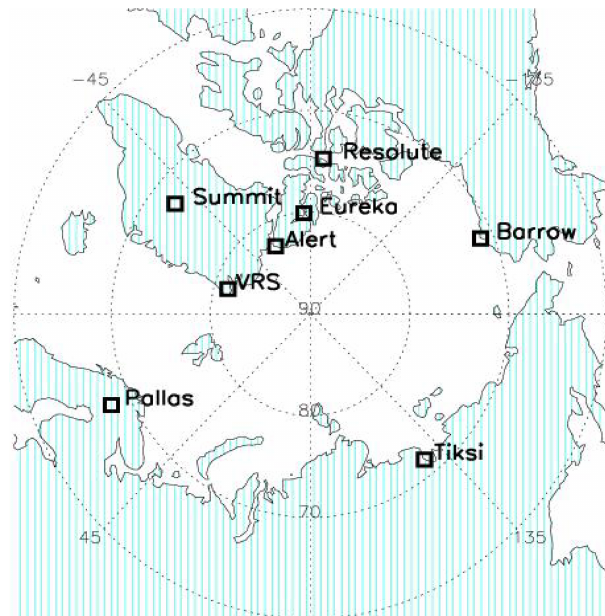
Figure 1. Map of the Arctic showing the locations of the eight Arc- tic sites where surface ozone and/or ozone-sonde data are used in this